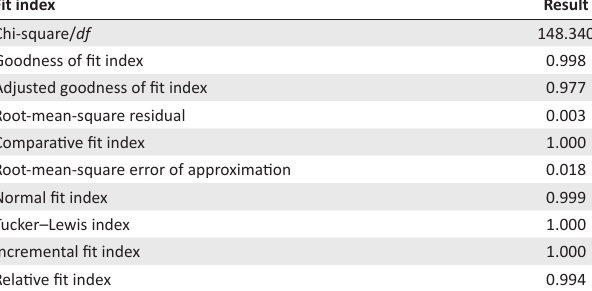
TABLE 5: Structural equation modelling – model fit index results.